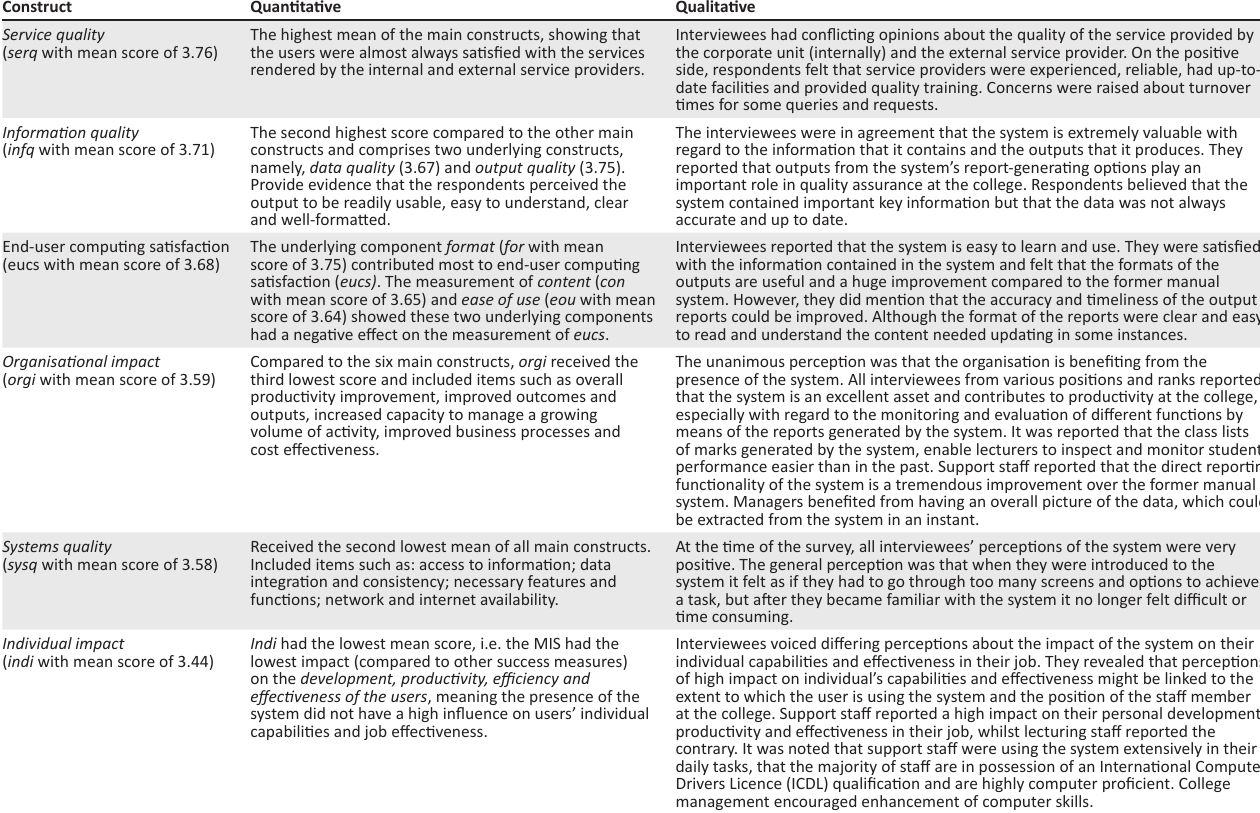
TABLE 3: Triangulation of quantitative and qualitative data with regard to evaluation constructs. Construct Quantitative Qualitative Service quality ( serq with mean score of